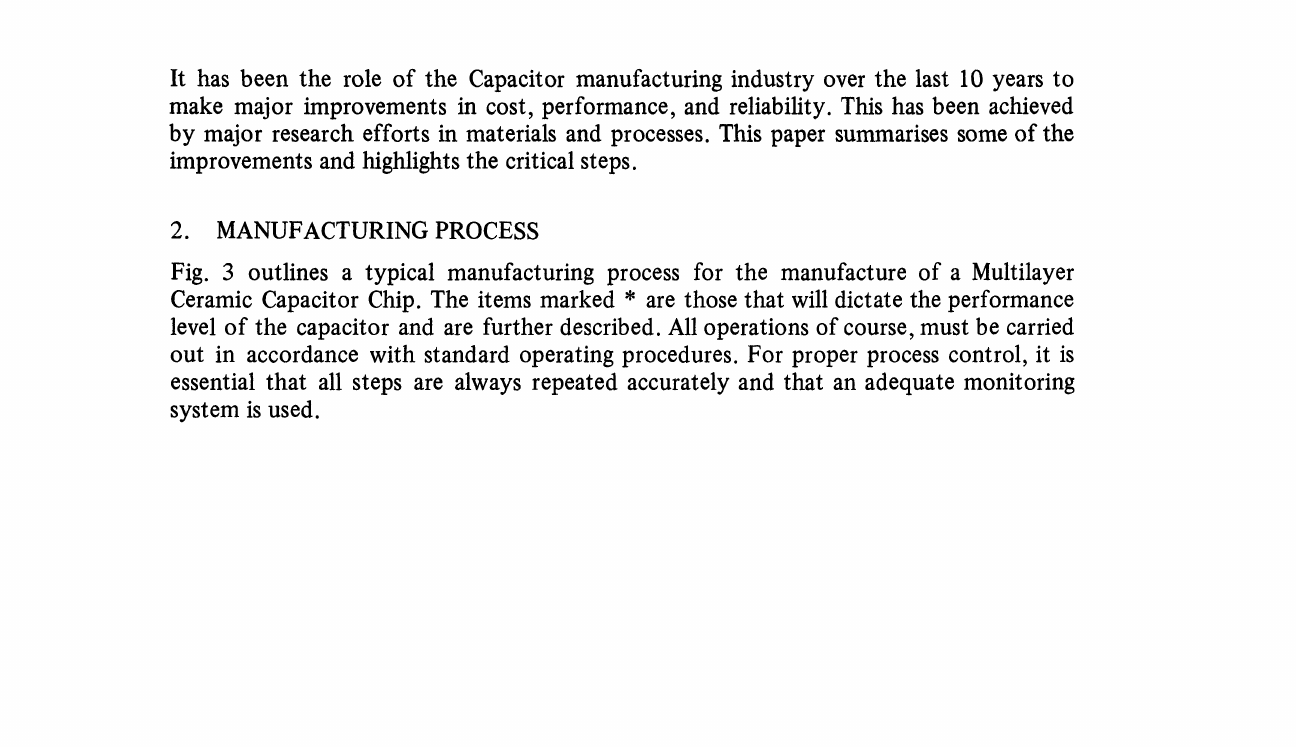
FIGURE Current time graph 16K